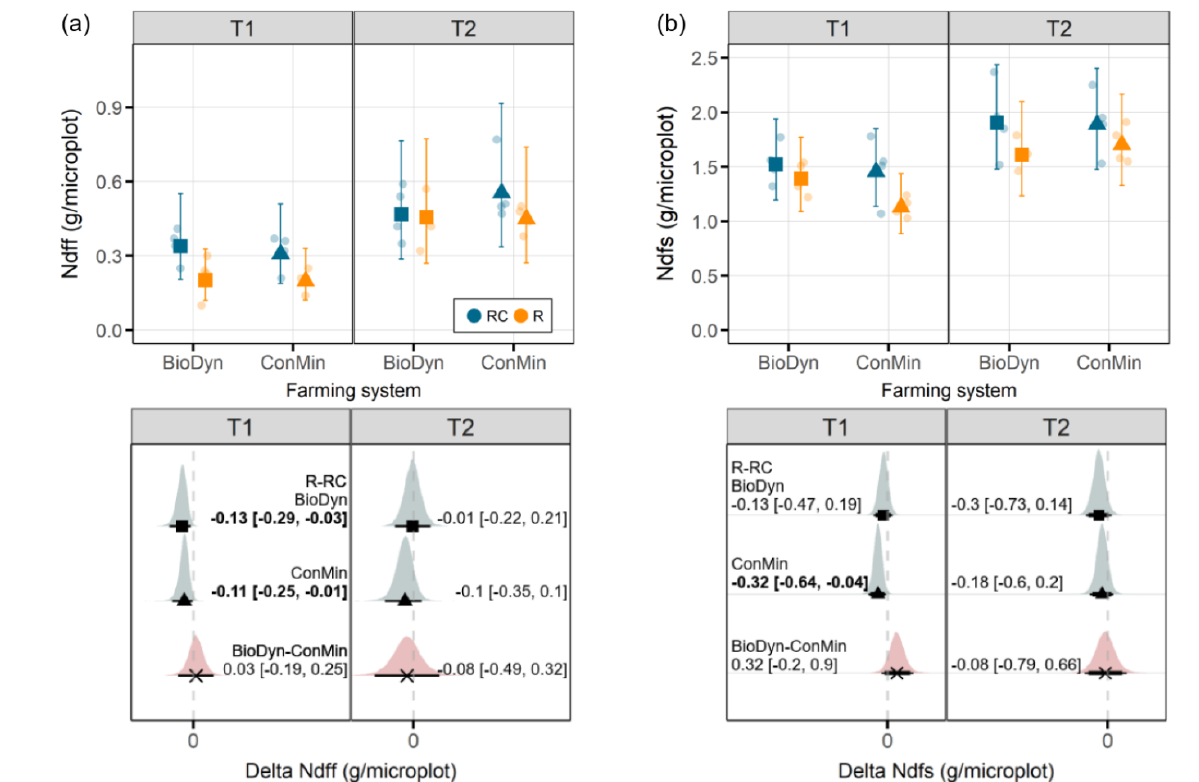
Figure 6. Upper panels: ( a ) total plant N derived from the fertilizer (Ndff) and ( b ) total plant N derived from the soil (Ndfs) pool. Semi-transparent points: raw data and lower panels: differences in the Ndff and Ndfs in response to drought treatments (R-RC in BioDyn: rectangle and R-RC in ConMin: triangle), along with differences between the farming systems (BioDyn-ConMin: cross; calculated as averages over the drought treatment). All data are medians of the posterior distribution with 95% credible intervals (CrIs), factor system: biodynamic farming system (BioDyn) and conventional farming system (ConMin), factor drought: rainout shelter control (RC) and rainout shelter (R) and factor sampling: first sampling (T1) and second sampling (T2). Credible intervals in bold exclude zero.